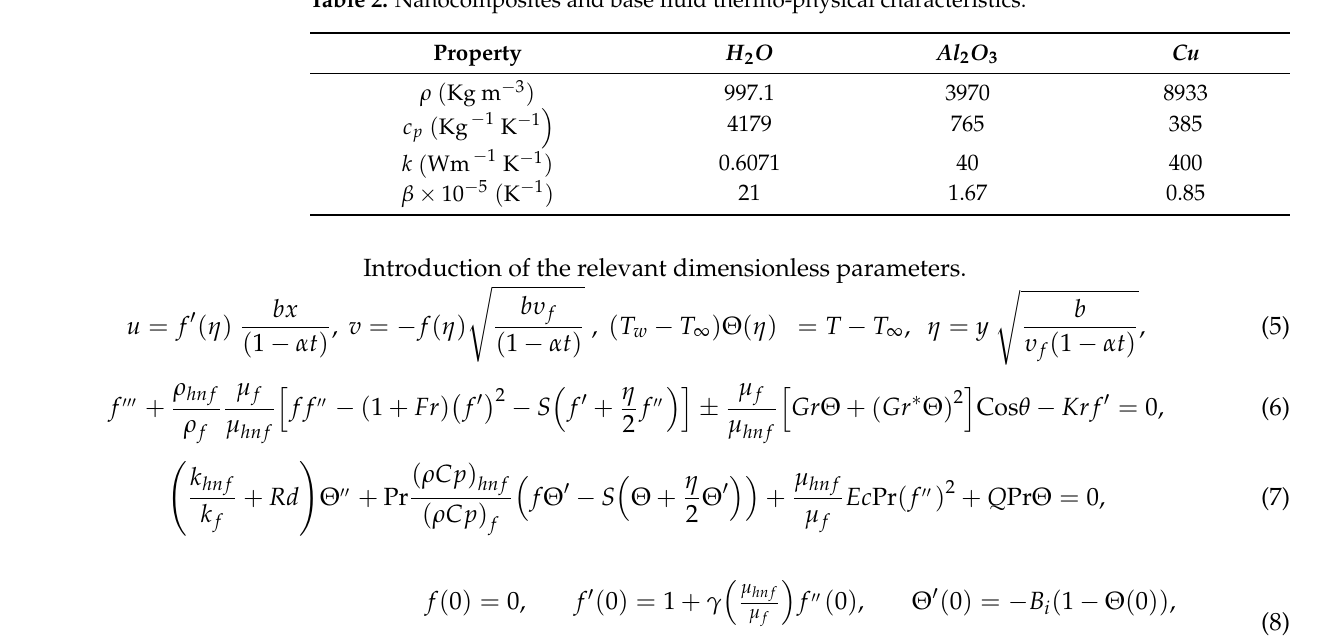
Table 2. Nanocomposites and base fluid thermo-physical